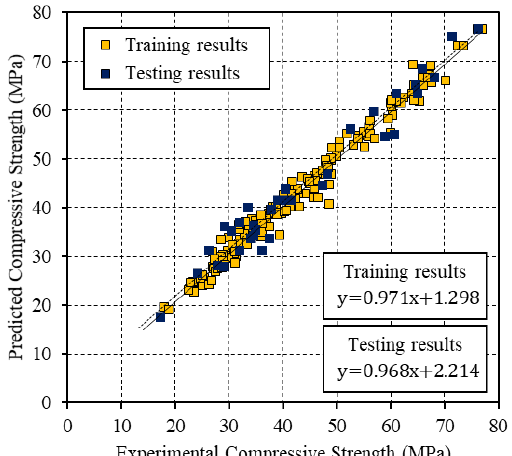
Figure 5. Comparison between the experimental CS and that predicted by the PSO neural network.